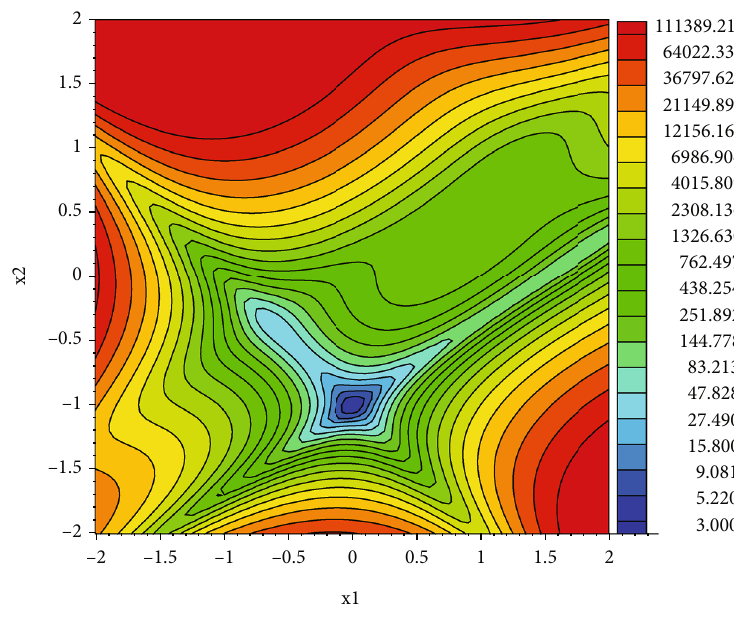
Figure 3: Original GP function.